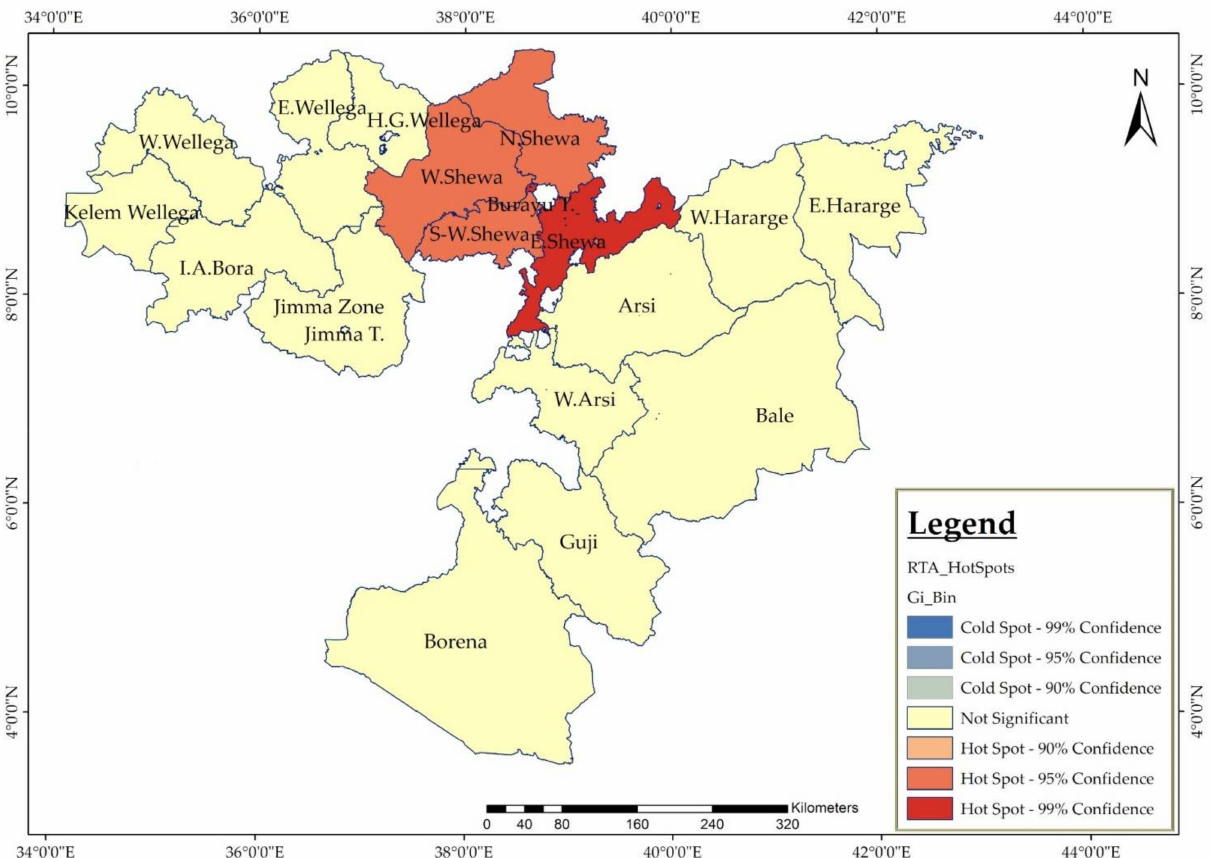
Figure 8. The spatial autocorrelation of Oromia in ( a ) Graph and ( b ) Attribute table.